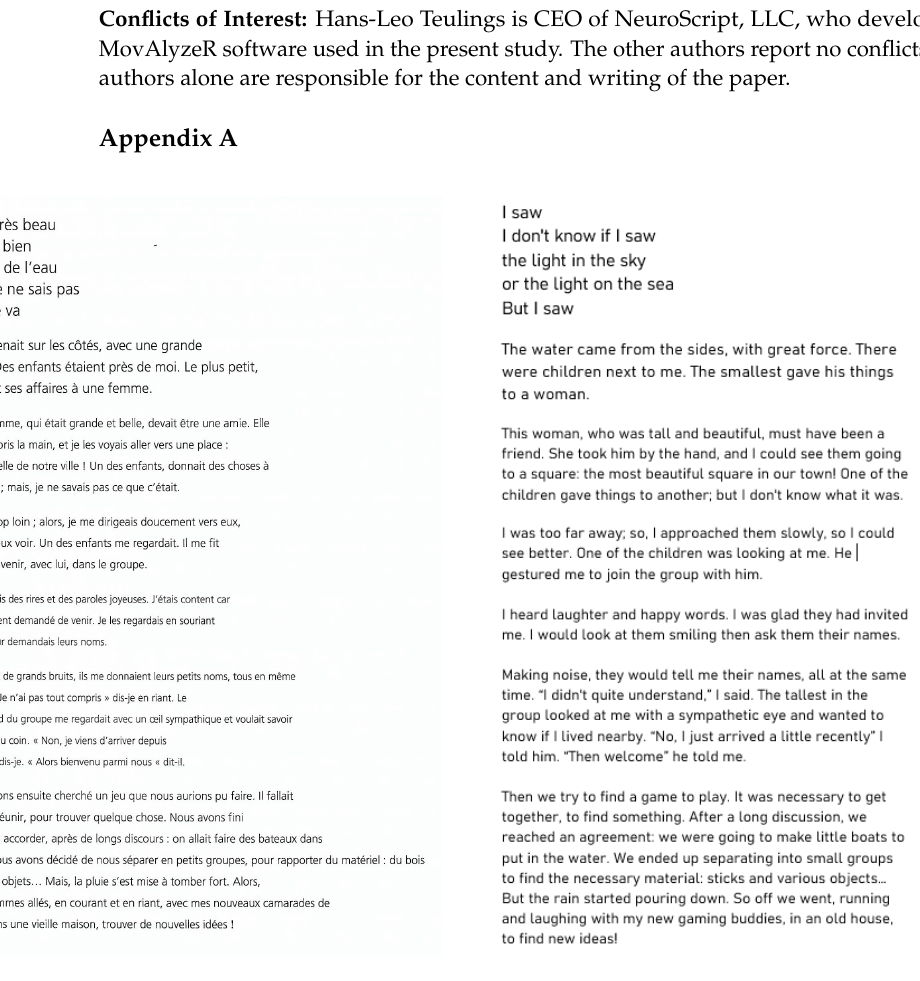
Figure A1. The French BHK text [15] (left panel) used to generate the cross-culturally adapted Portuguese version (shown in Figure 2) and the literal translation of the Portuguese version into English (right